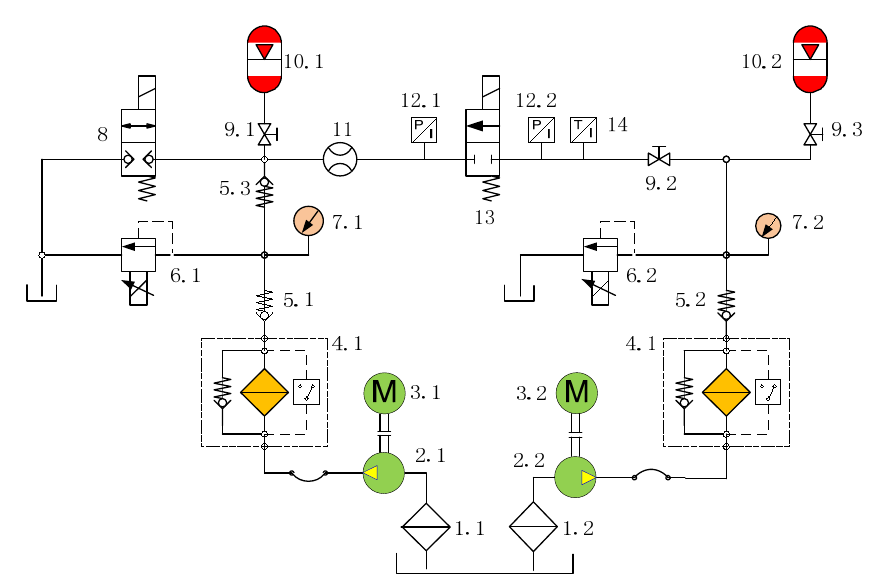
Figure 5. Schematic diagram of a micro digital valve test system. 1.1 and 1.2: Crude filter; 2.1 and